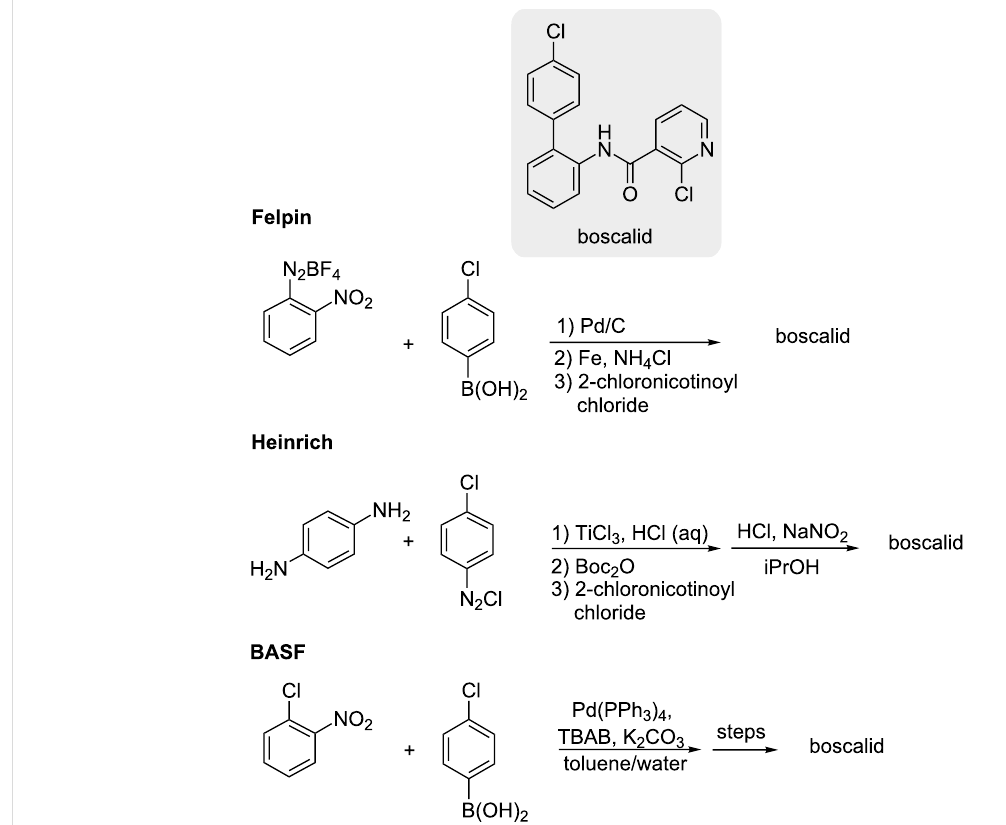
Scheme 6: Previous syntheses of boscalid ® .